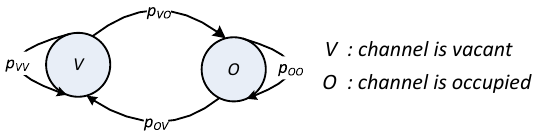
Figure 2. Model of the primary channel.